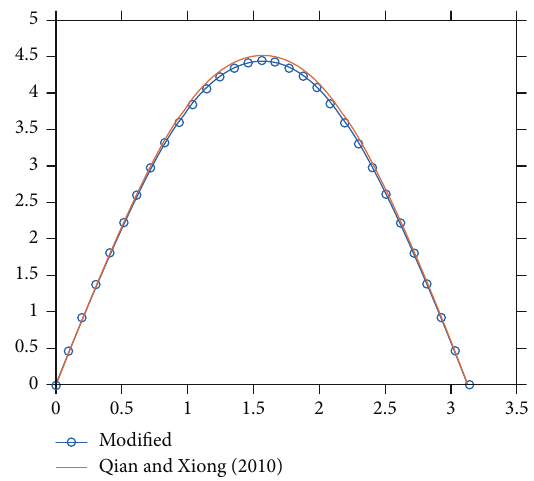
Figure 18: The variations of the system of equations (46) and the solution of the regularized system of equations (12) – (15) for p = 1 , k = 1 : 4 , α = 0 : 0001 , and y = 1